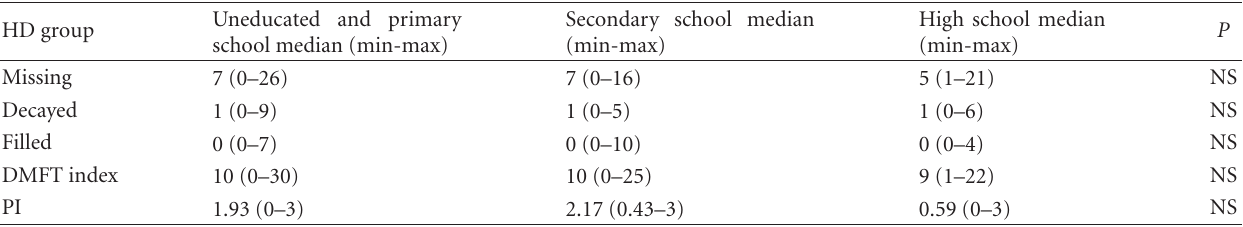
Table 4: Median (min-max) values and statistical comparisons for decayed, missing, and filled teeth, DMFT index, and PI in the HD group. HD